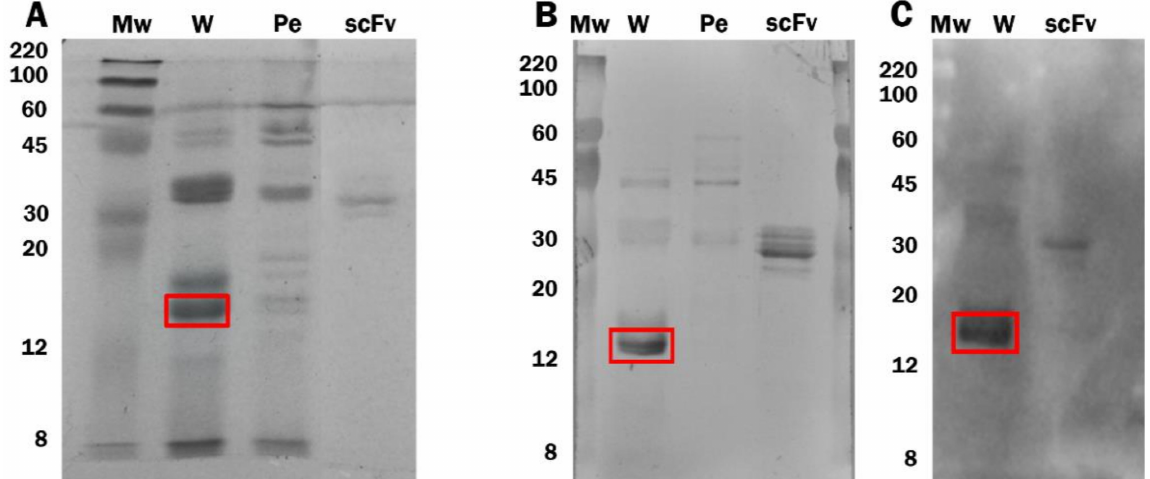
Figure 3. SDS-PAGE electrophoresis ( A ) and JrBSF scFv immunoblots ( B , C ) of 10 µ g walnut extract (W), 10 µ g pecan extract (Pe), and 2 µ g purified JrBSF (scFv). Mw of the protein marker bands (ColorBurst TM Electrophoresis Protein Marker, Sigma) is indicated. JrBSF scFv in the immunoblots was detected either with Anti-c-Myc monoclonal antibody (9E10) and alkaline phosphatase (AP) conjugated anti-mouse IgG ( B ) or with horseradish peroxidase (HRP) conjugated Anti-6X His tag ® antibody (ab1187) ( C